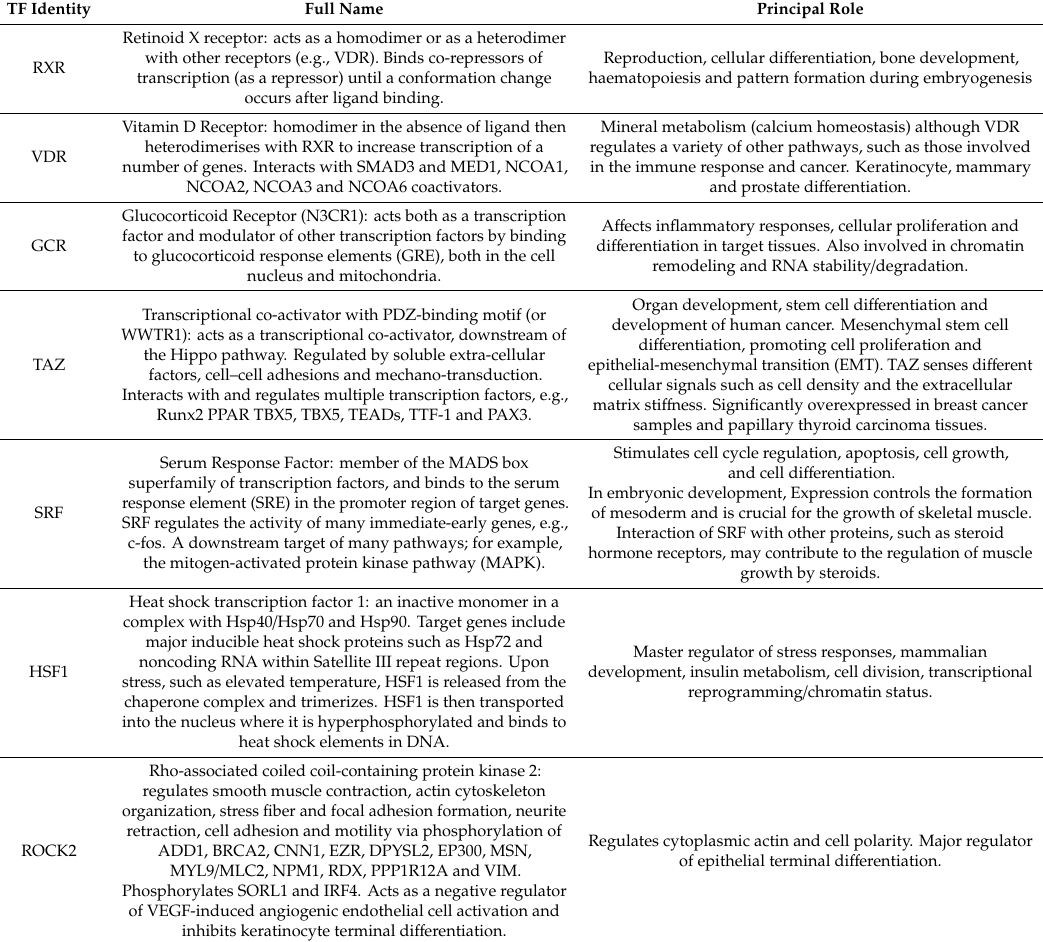
Table 2. Major transcription factors implicated in prostate epithelial cell di ff